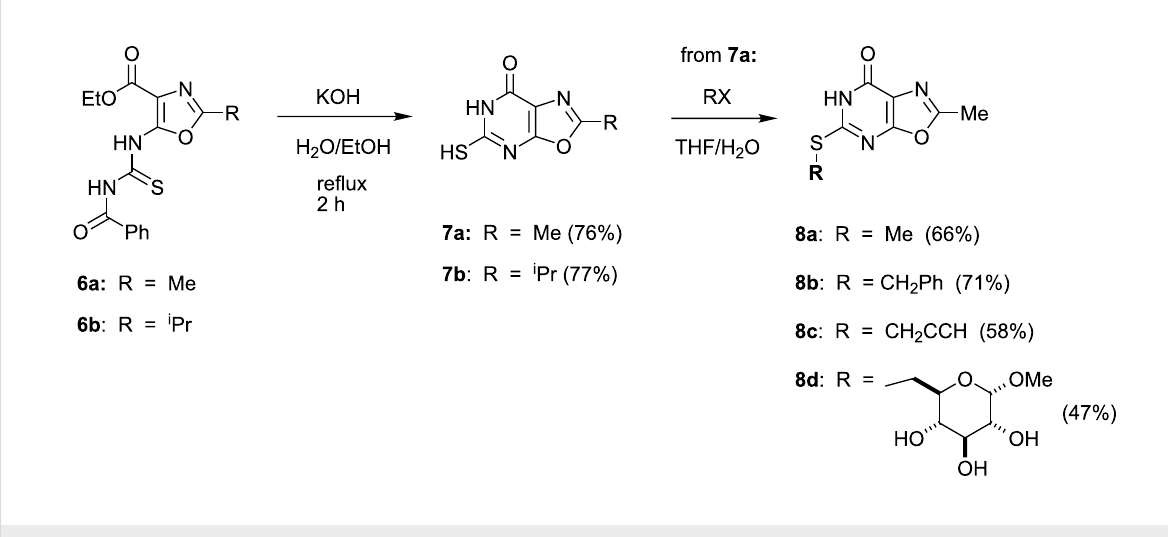
Figure 4: Preparation of 2-substituted 5-aminooxazolo[5,4- d ]pyrimidin-7(6 H )-ones and related